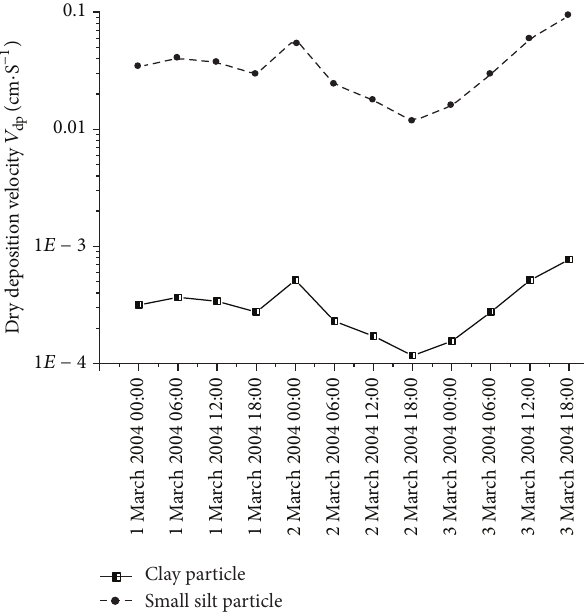
Figure 9: Evolution of turbulent deposition velocity at the top of viscous sublayer 𝑧 𝑠 above the Island of Gran Canaria from 1 to 3 March